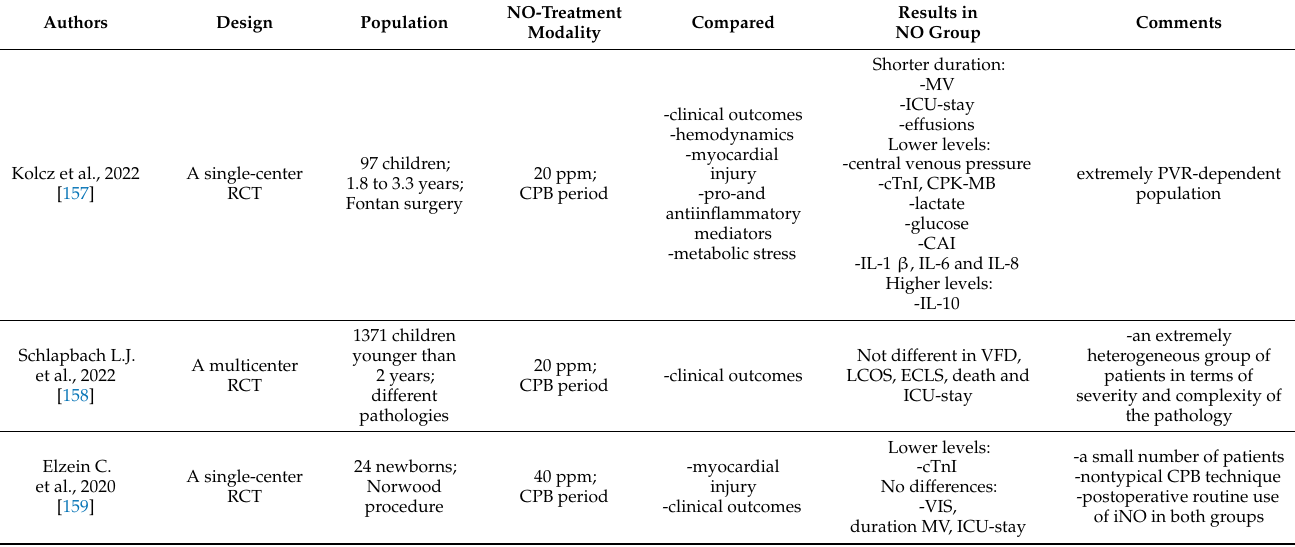
Table 3. Clinical studies using low-dose iNO (<80 ppm). Studies of cardioprotective effects of NO in different categories of patients in terms of cardiac